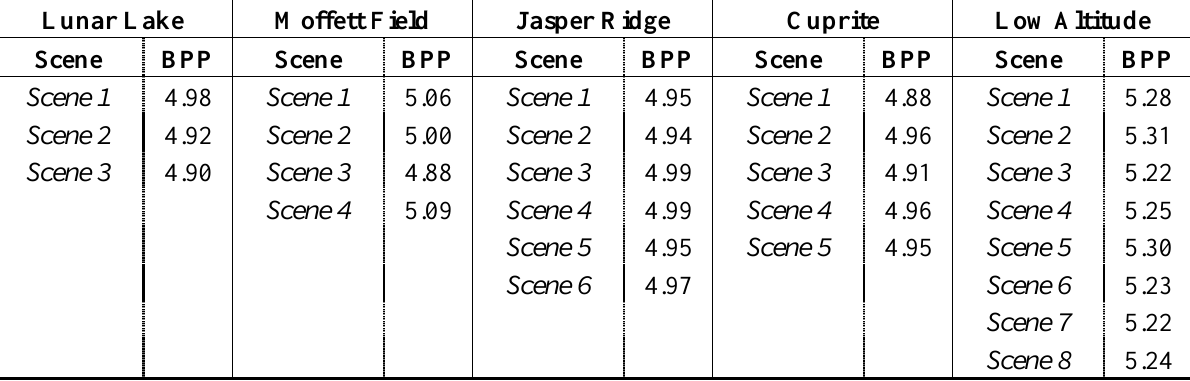
Table 5. Results (BPP achieved for each scene of the hyperspectral imagery with Pearson’s correlation-based band ordering).